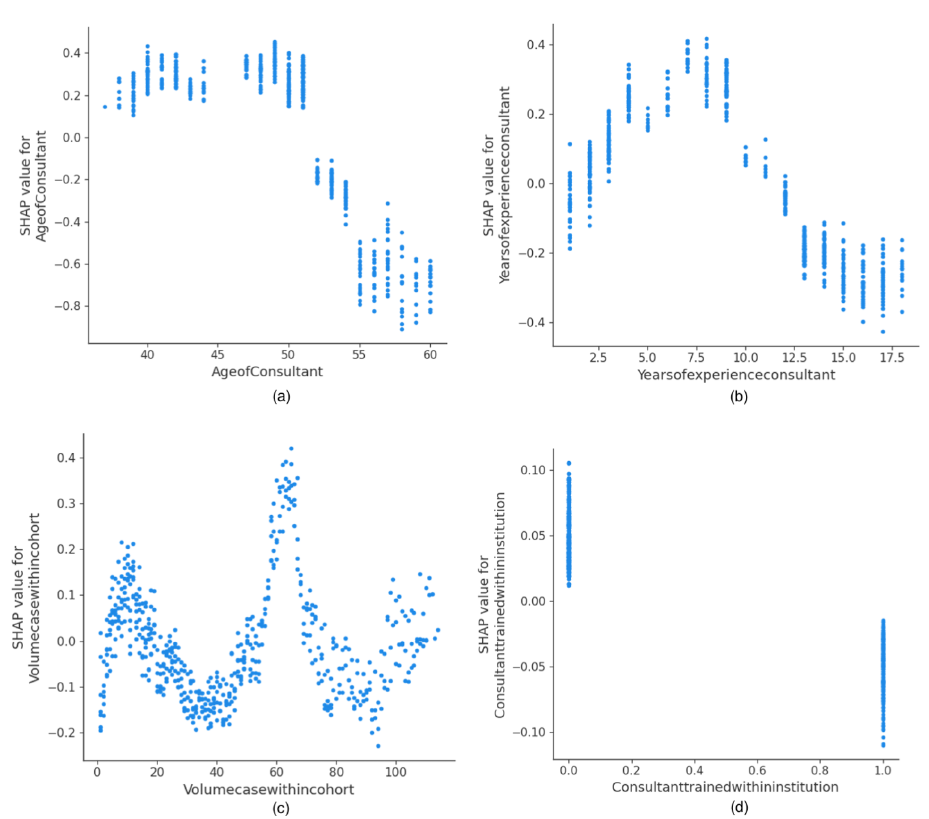
Figure 4. Examples of SHAP Value Dependence plots for global explainability features reflecting human factors showing the impact of each feature value on the prediction: ( a ) Consultant Age,